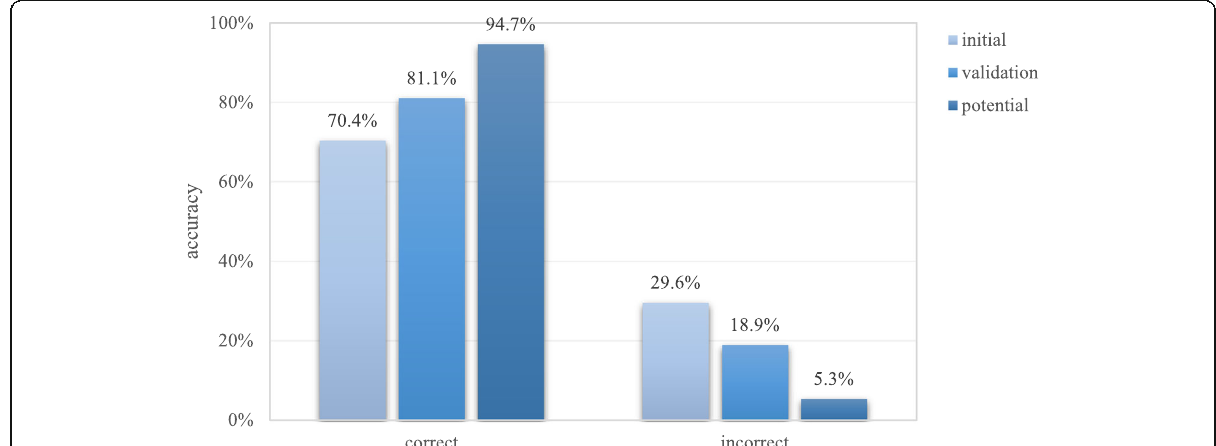
Fig. 8 Accuracy and potential accuracy of trip